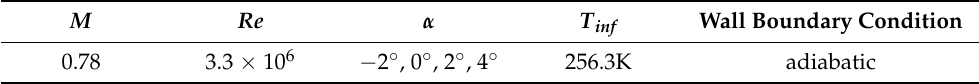
Table 3. Parameters of Case 1.